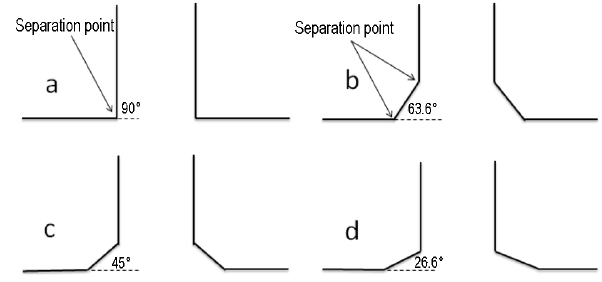
Fig. 6. The connection angle between the shaft and